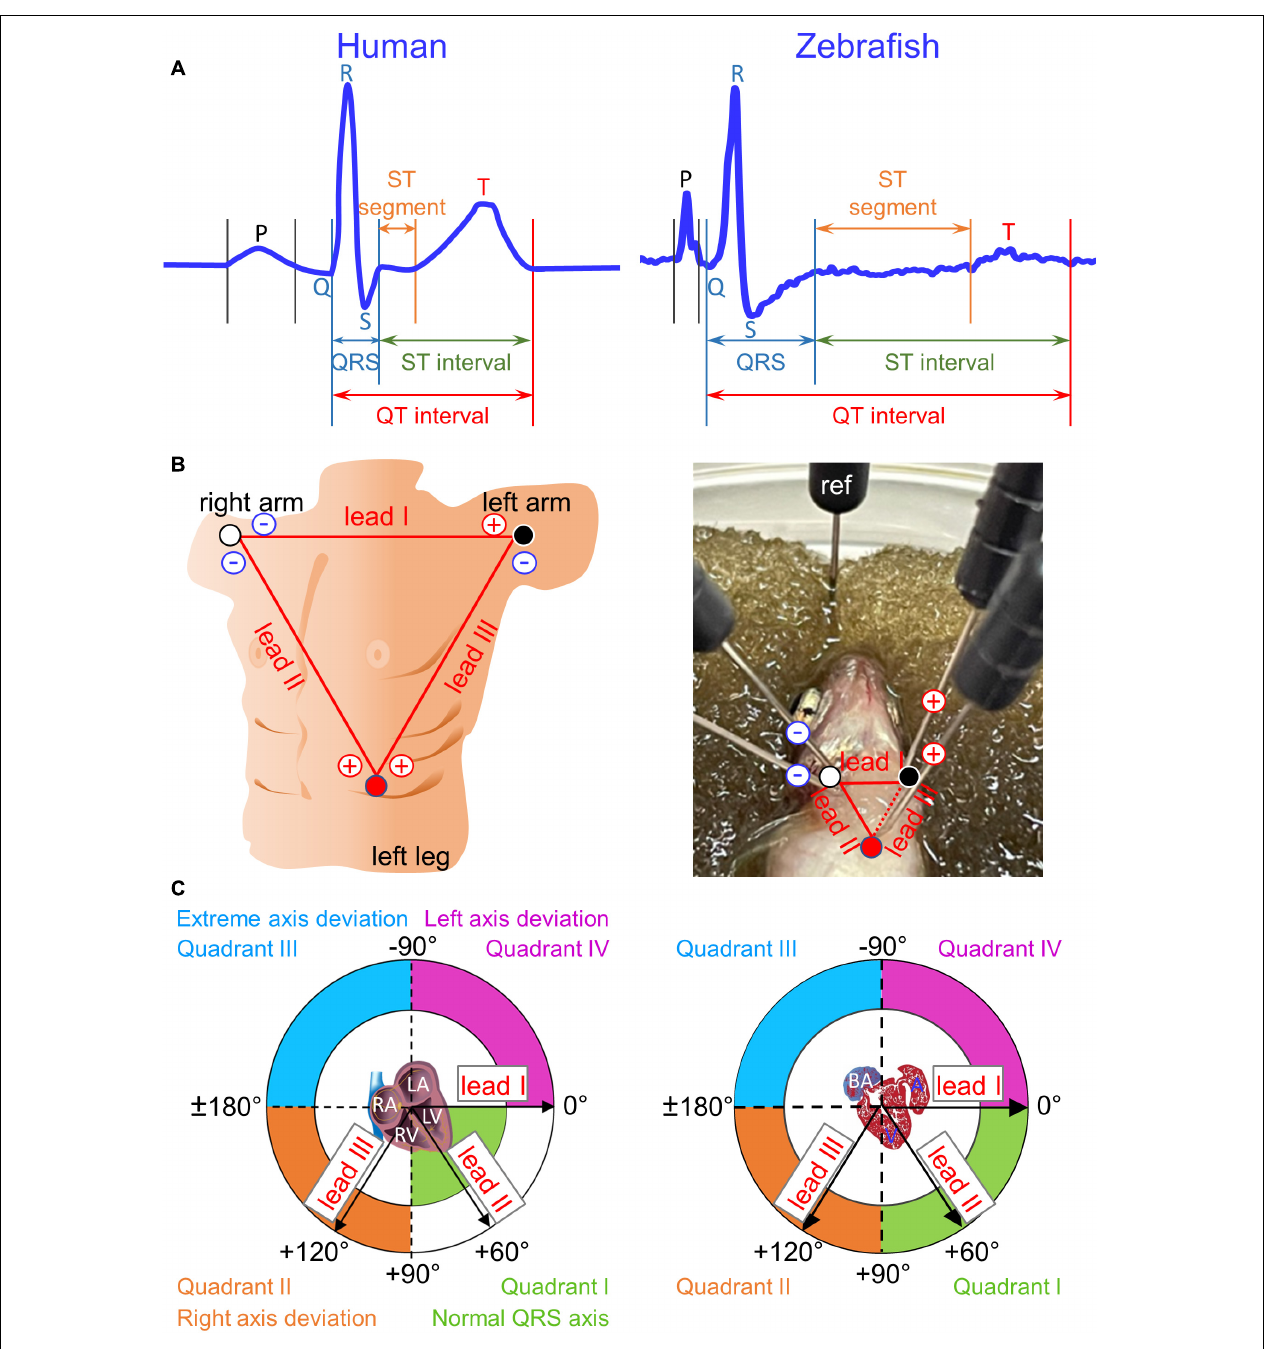
FIGURE 1 | Einthoven’s triangle and Cabrera circle. (A) Definitions of durations for waves (P, Q, R, S, and T), intervals (QRS, QT, and ST), and segments (ST) are illustrated in two magnified and stretched normal cardiac cycles from human lead II (manual tracing over actual recording) and from zebrafish lead reverse II (rII). The normal physiological Q wave is typically absent or barely visible in adult human lead II and adult zebrafish lead rII. (B) To construct human Einthoven’s triangle, three pairs of electrodes for three bipolar Einthoven leads are placed on both arms and the left leg to represent the three sides of an imaginary inverted equilateral triangle enclosing the human heart. To construct zebrafish Einthoven’s triangle, we inserted two pairs of electrodes for the two bipolar Einthoven leads, such as leads I and II (solid lines). Since all three Einthoven leads relate by Einthoven’s law (II = I + III), the Cardiac Axis Extension algorithm (ADInstruments) derived the remaining lead III (dashed line). For grounding, we inserted the fifth electrode, the reference (ref) electrode, either in the damp sponge or in the zebrafish anal region. (C) We numbered the four 90 ◦ -quadrants of the Cabrera circle clockwise, roughly corresponding to human “normal QRS axis,” “right axis deviation,” “extreme axis deviation,” and “left axis deviation.” The human QRS axis defines the main heart axis, which normally averages +60 ◦ but the range of normal values is wide, encompassing from –30 ◦ to +105 ◦ , spilling from Quadrant I onto Quadrants II and IV. The zebrafish electrical heart axes and main heart axis were not known prior to our study. RA/LA, right/left atrium; RV/LV, right/left ventricle; BA, bulbus arteriosus; A, atrium; V, ventricle.